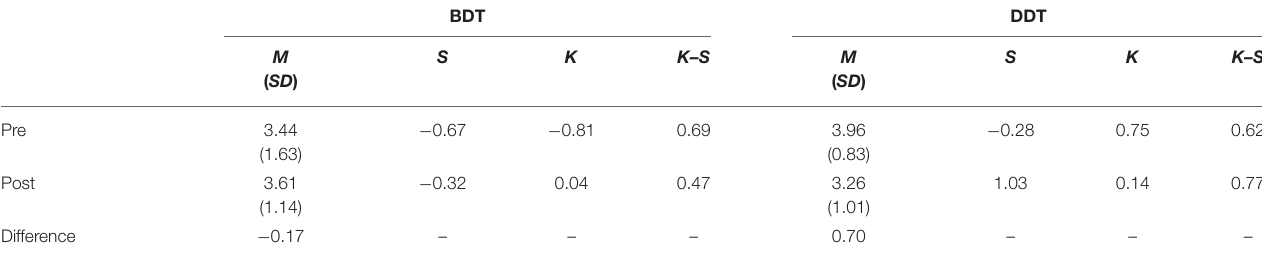
TABLE 8 | Discrimination sensitivity ( d ′ ) of BDT and DDT before and after the mindfulness training in elite archery athletes of the national team ( n = 14). BDT